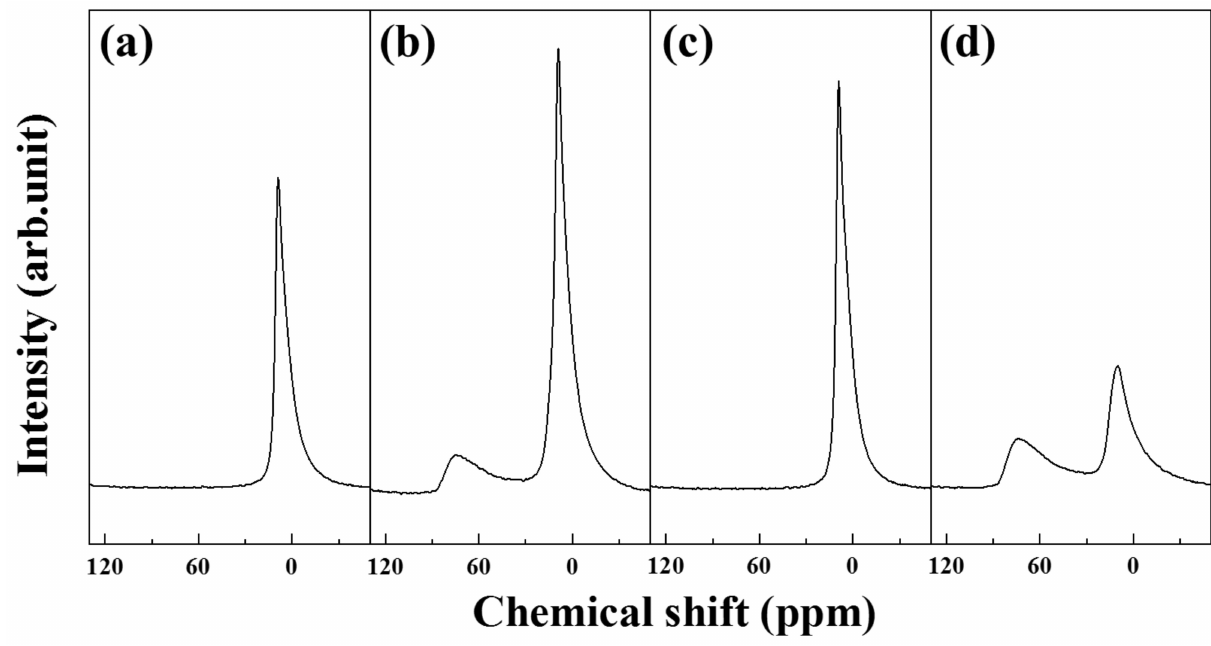
Figure 4. Solid state 27Al MAS-NMR spectra of ( a ) AH-1, ( b ) AO-1, ( c ) AH-2, and ( d ) AO-2. Peaks at around 10 ppm and 75 ppm were assigned to Al3+ (O h ) and Al3+ (T d ), respectively. Table 1. Physicochemical parameters obtained from solid state 27 Al MAS-NMR spectra and N 2 adsorption-desorption